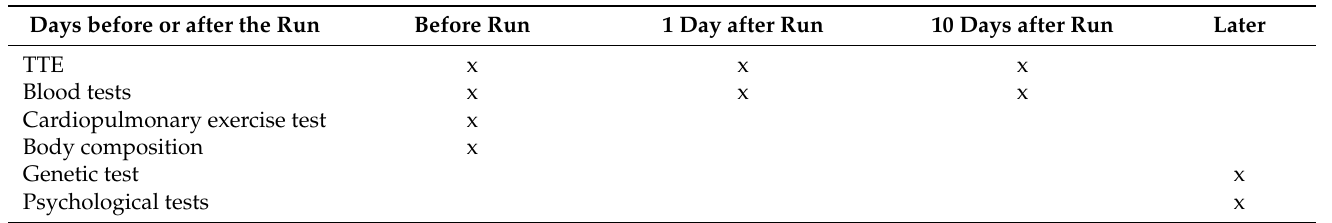
Table 2. Date and type of medical